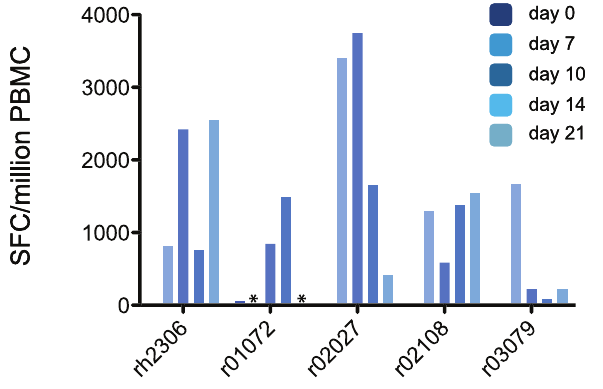
Table 2. Serum antibody titers against pandemic virus CA04.